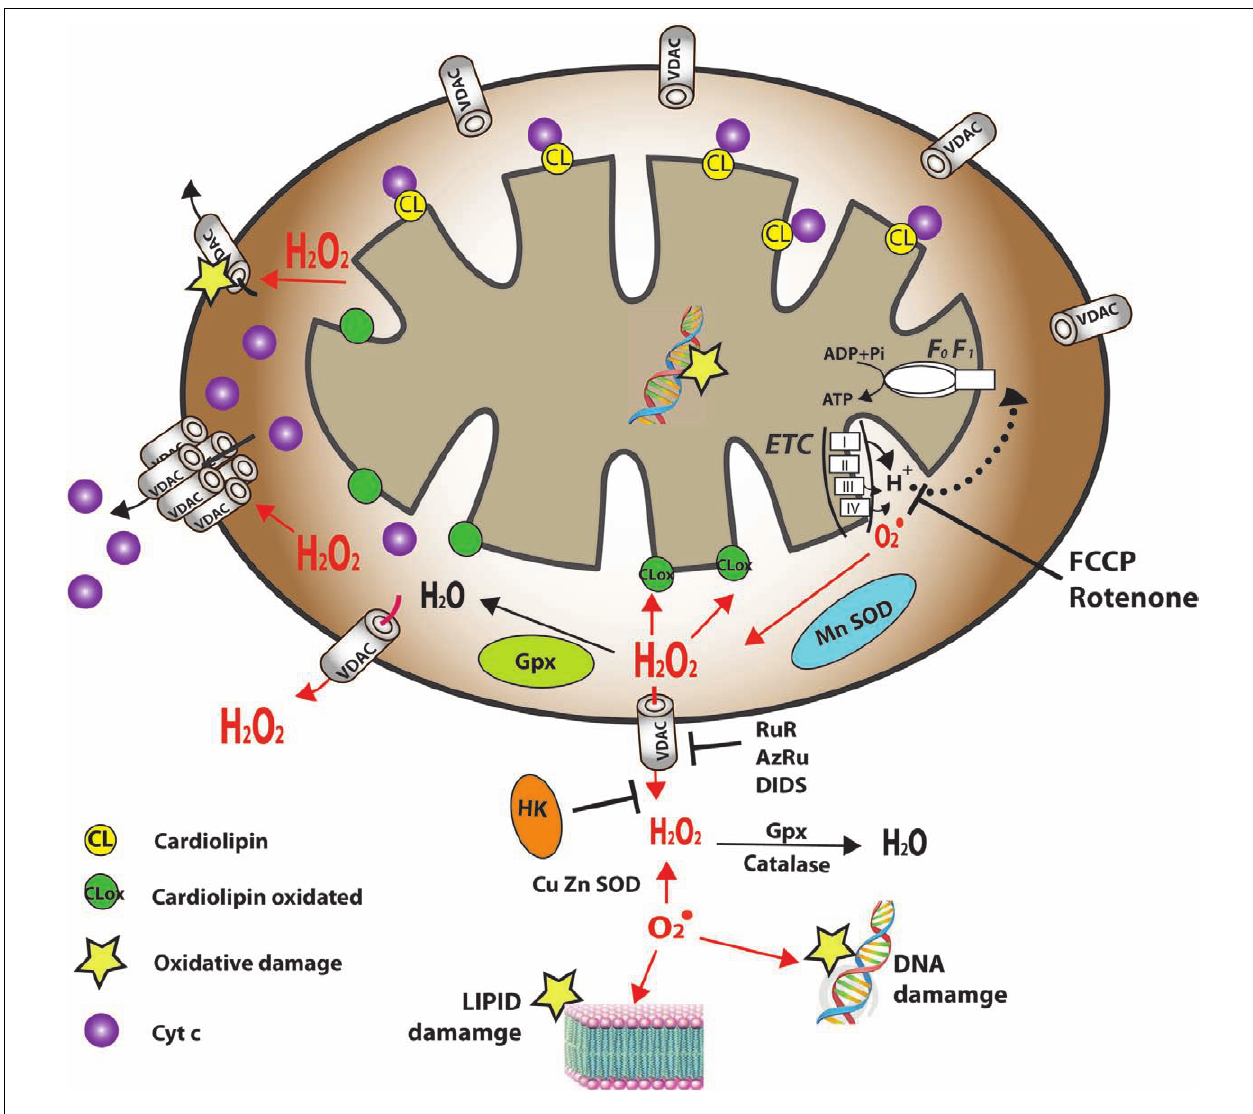
FIGURE 7 | Reactive oxygen species occlusion and degradation in mitochondria can prevent cell damage. A schematic presentation summarizing current knowledge and proposed control mechanisms for ROS production, neutralization, and cellular effects (seeVDAC1 Function in ROS Release, ROS-mediated Apoptosis and Interaction with NO). Free radicals generated by the electron transport chain are generally regarded as toxic metabolites and, as such, are degraded by specialized enzymes, namely catalases, peroxidases, superoxide dismutases, and glutathione peroxidase. Mitochondrial ROS cross the OMM viaVDAC.The ROS that escapes catalytic removal can cause oxidative damage ( ) to mitochondria, and when released